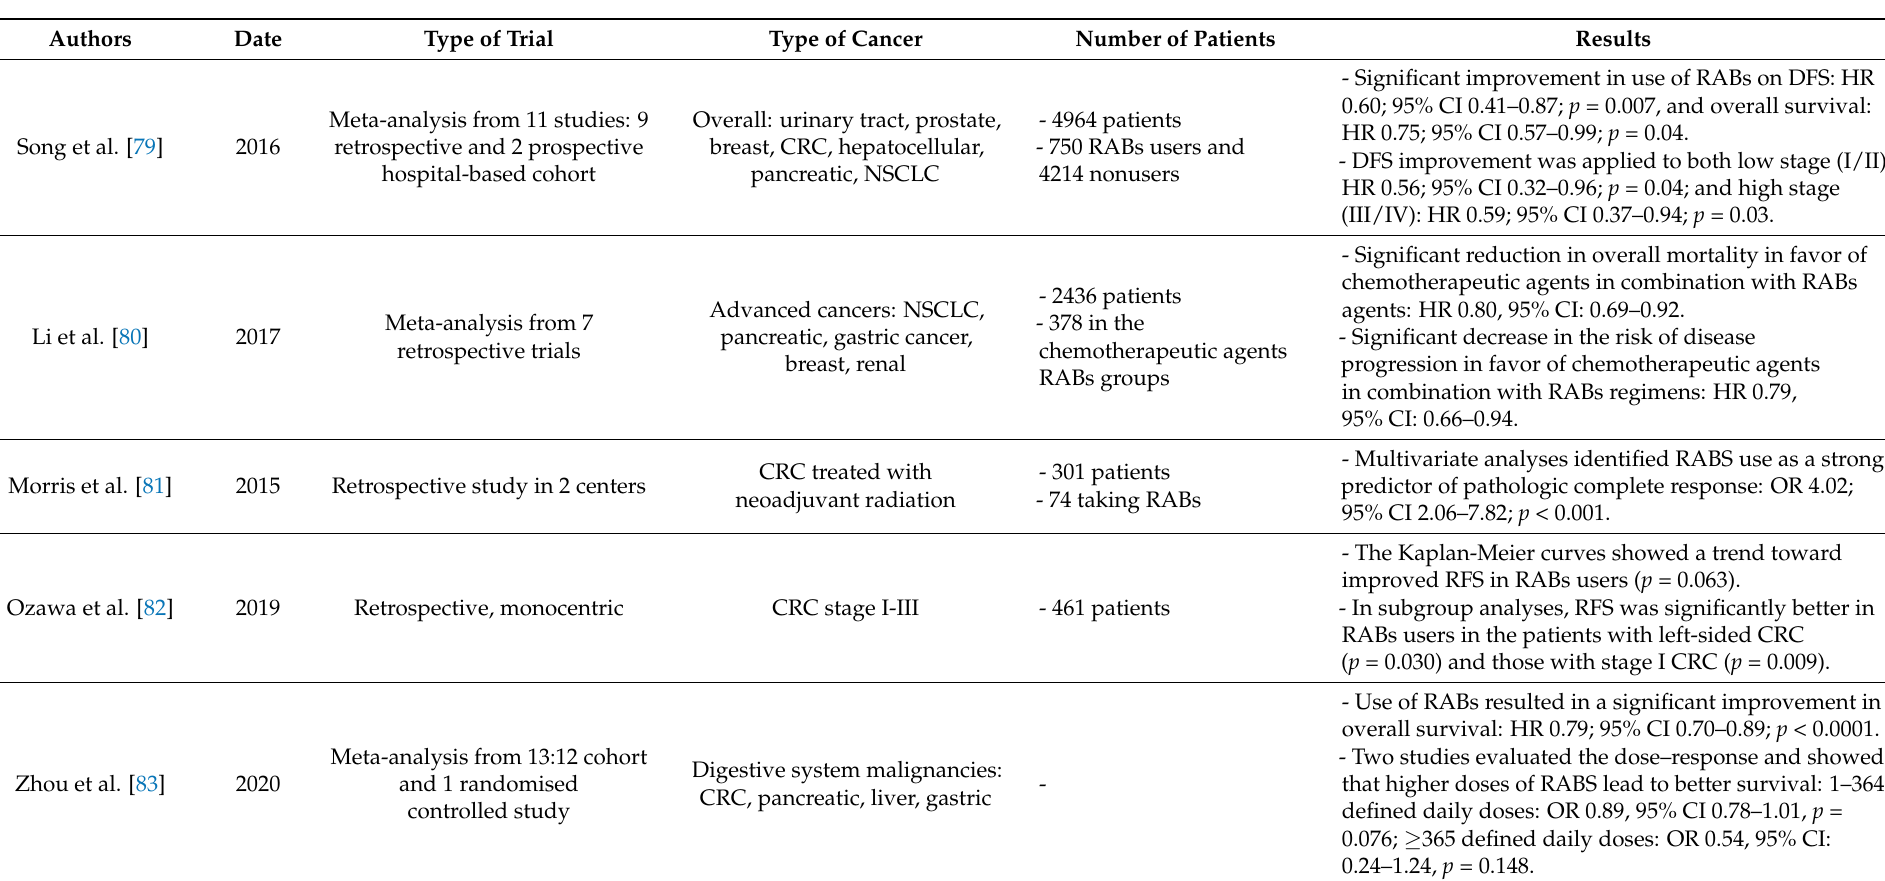
Table 3. Summary of RAB and cancer survival studies. Abbreviations: ACEIs: angiotensin-converting enzyme inhibitors, ARBs: angiotensin-2 receptor blockers, CI: confidence interval, CRC: colorectal cancer, DFS: disease free survival; HR: hazard ratio, NSCLC: non-small cell lung cancer, OR: odds ratio, RABs: renin-angiotensin-aldosterone system blockers, RFS: recurrence free survival, RR: risk